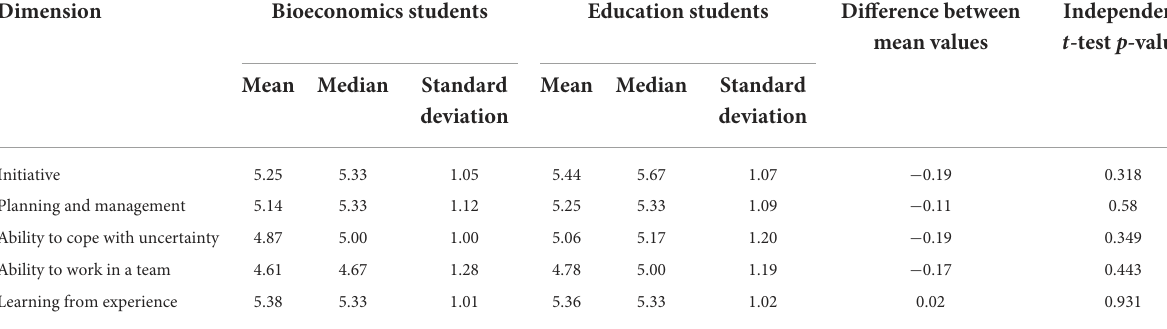
TABLE 8 Results of students’ self-assessment of the initiative and action orientation sub-competence.